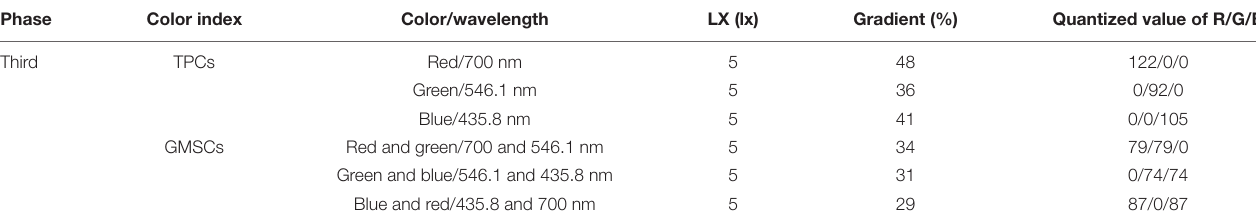
TABLE 3 | The gradient and quantized RGB values of the TPCs and the GMSCs at 5 lx for the third